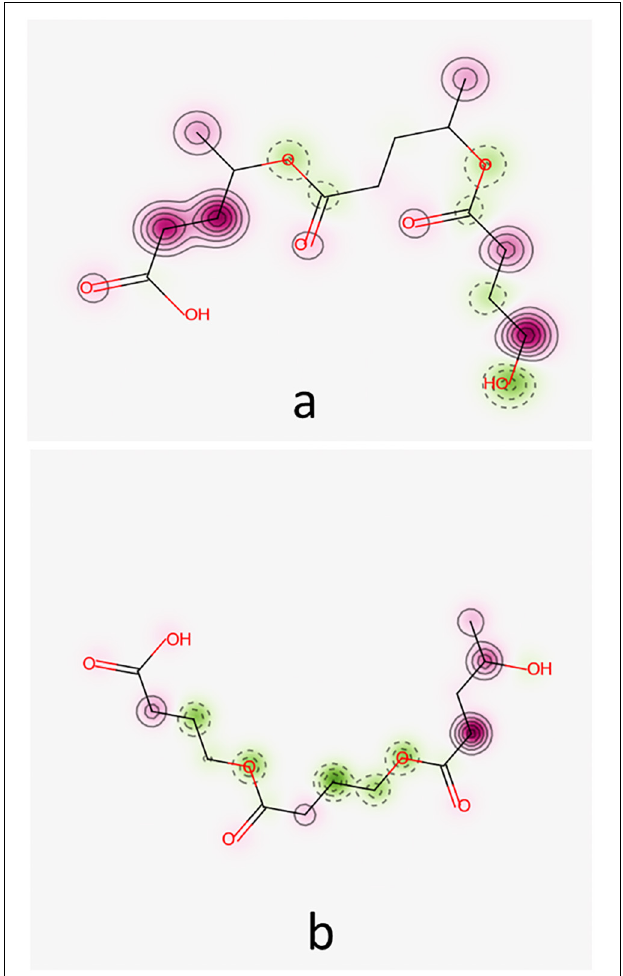
FIGURE 5 | Probability maps illustrating the contribution of fragments of co -oligomers O4HBVV (a) and O4HVBB (b) to skin sensitization potential based on KeratinoSens model. Fragments in green illustrate an increase in skin sensitization potential, the pink fragments contribute to decrease of skin